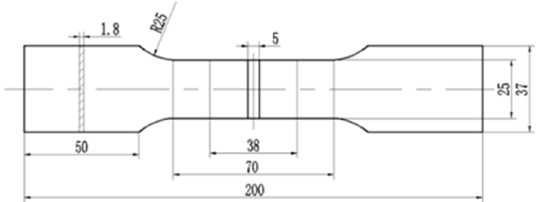
Figure 2. Specimen for tensile strength test of longitudinal weld.